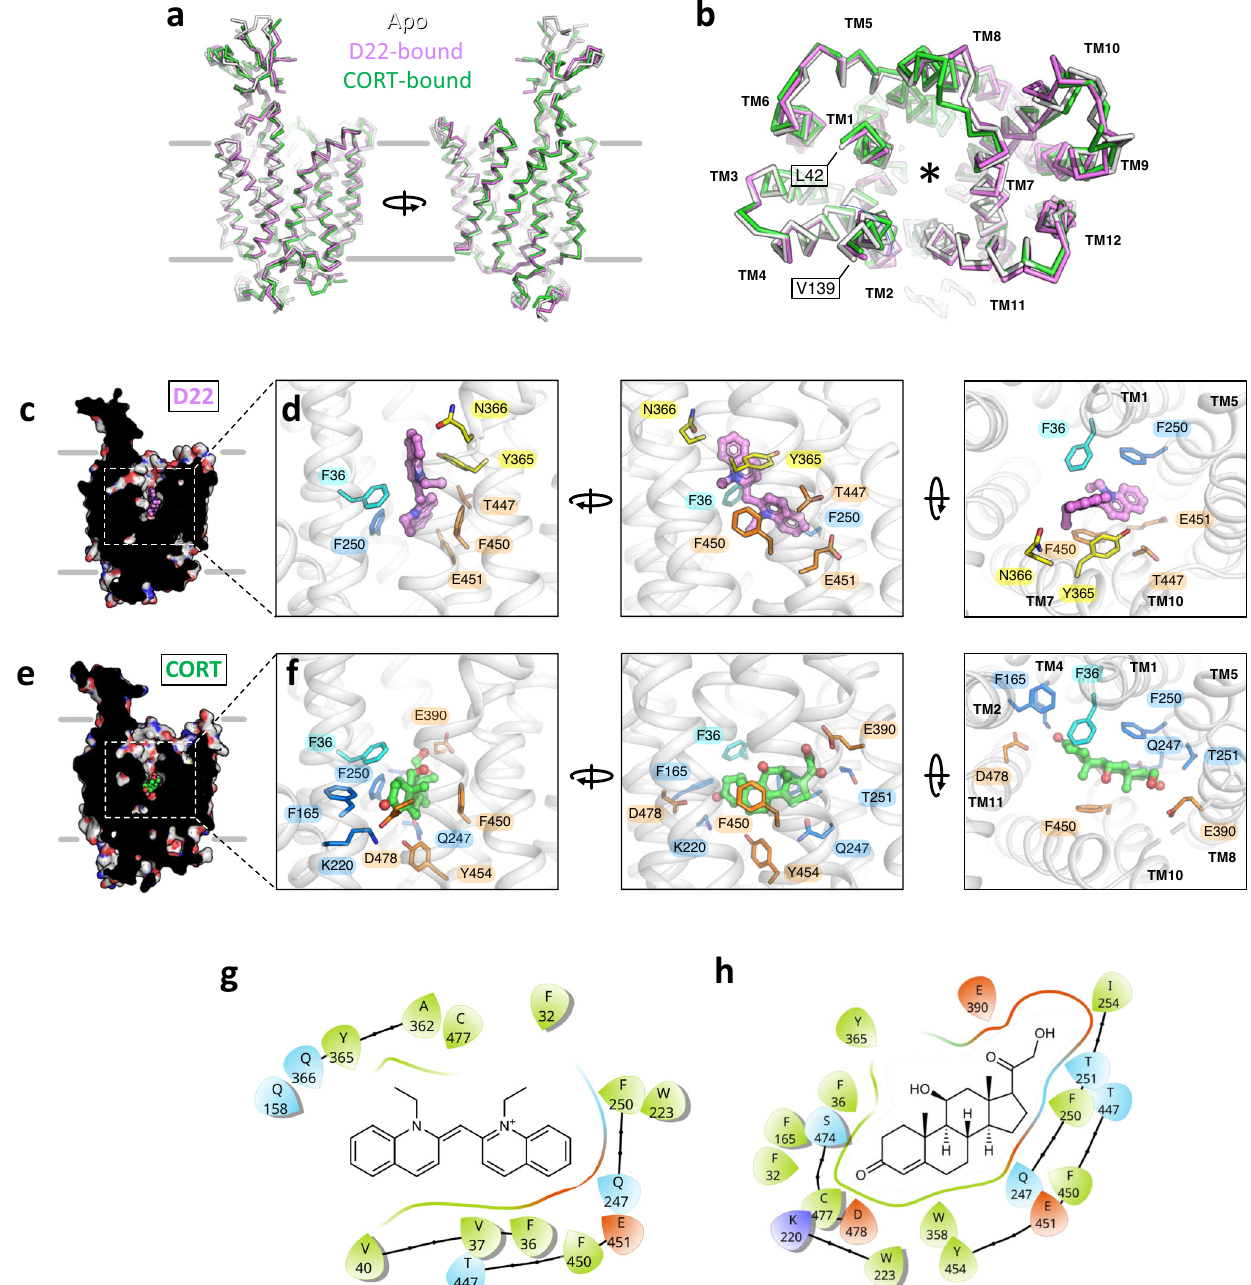
Fig. 2 | Comparison of the apo-state and the ligand-bound states of OCT3. a Structural alignment of the three indicated states of OCT3 shows an overall high degreeofsimilarity. b Sameasina,viewfromtheextracellularspace.Thepositions of each transmembrane (TM) helix are indicated. The residues fl anking the exten- ded extracellular loop 1 (ECL1) are indicated with boxes (L42 and V139). The translocation pathway / ligand binding site is indicated by an asterisk. c A sliced